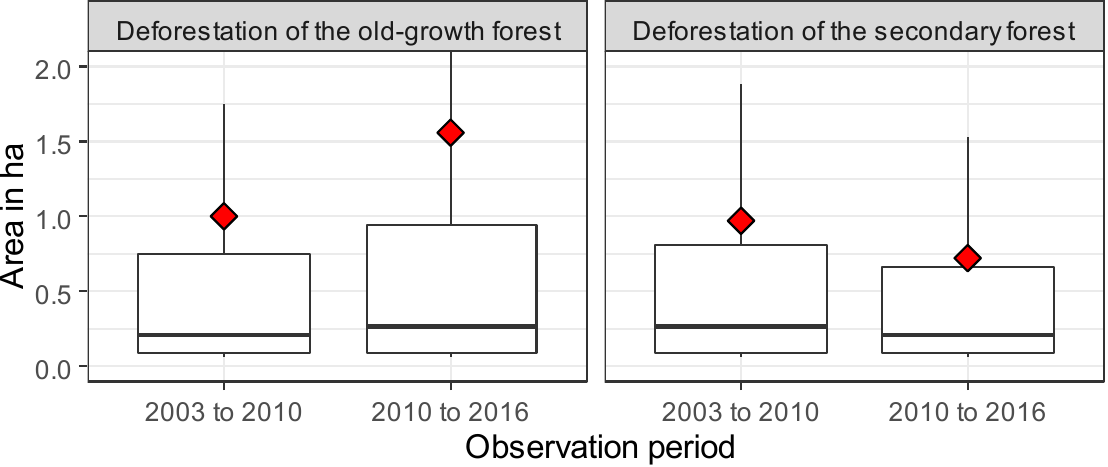
Figure 4. Variation in deforestation areas between 2003 and 2016.